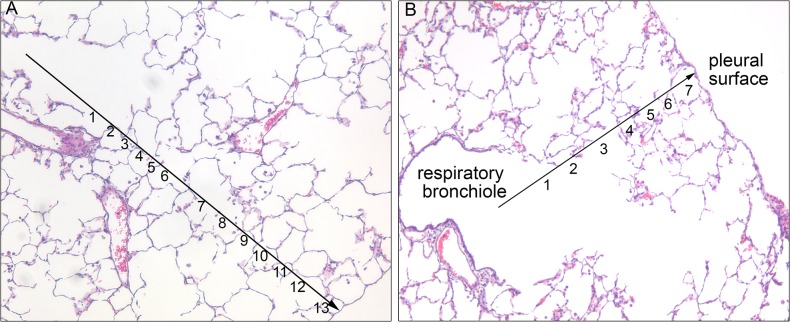
Radial alveolar count.Alveolar histology of a representative (A) Normal and (B) Severe rabbit showing the radial alveolar count. A line is drawn from the center of the respiratory bronchiole perpendicular to the nearest interlobular septa, each saccule bisected by this line is counted.